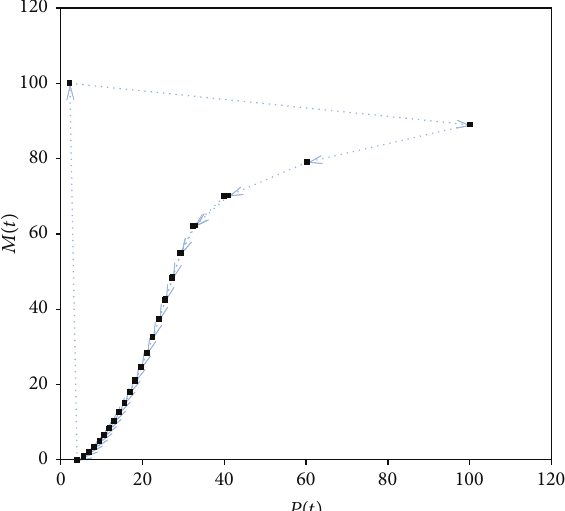
Figure 3: A cycle example. Here, all the parameters remain the same as the ones in Figure 2 except the initial states. As starting points, 𝑃 0 = 40 and 𝑀 0 = 70 are applied to this example.